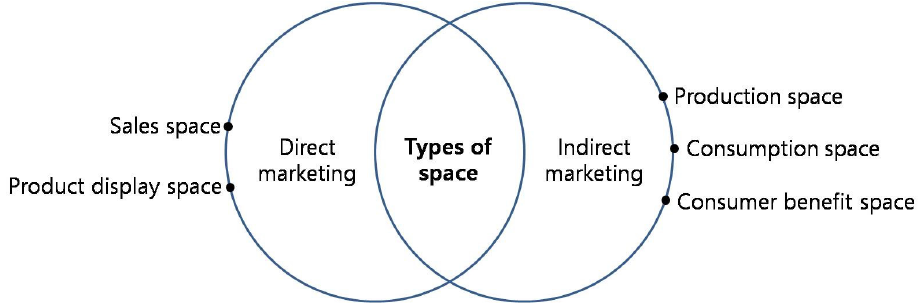
Figure 1. Types of space from the marketing perspective.